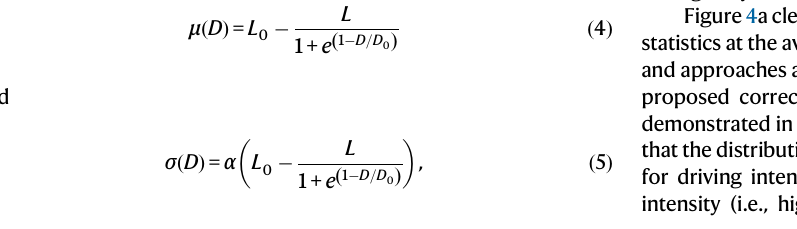
samples of Swedish vehicle retirement statisticsfor 2014 – 2018 are provided in the background for comparison. The color indicates the driving intensity class of the data